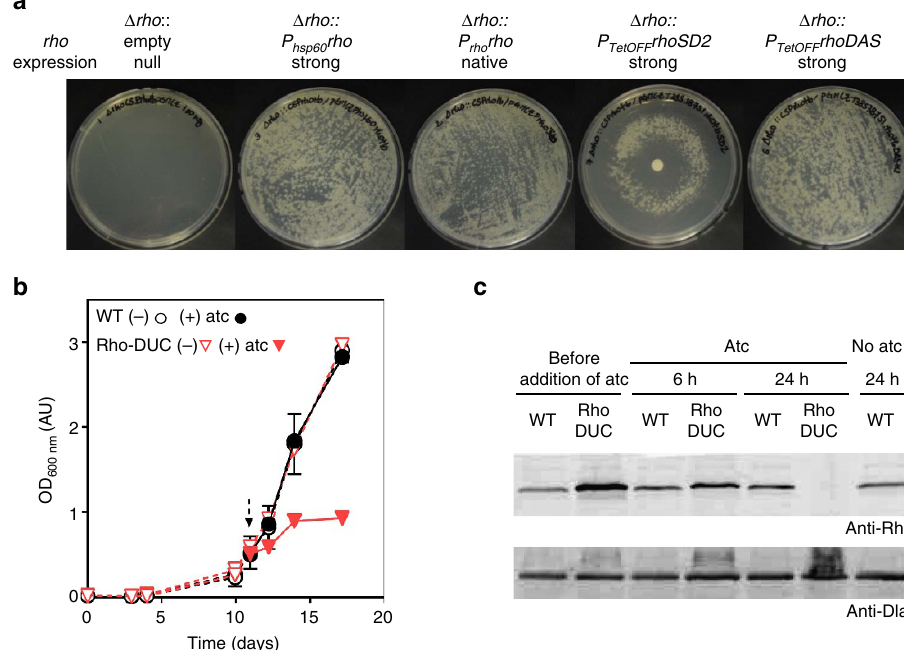
Figure 1 | The gene rho is essential for the growth of M. tuberculosis . ( a ) Phenotypes of different rho mutants on rich solid medium. Rho was either deleted ( D rho) or exchanged against rho expressed under the control of the hsp60 promoter ( P hsp60 rho ), the native promoter ( P rho rho ) or transcriptionally regulated TetOFF promoters ( P TetOFF rho SD2, P TetOFF rho DAS). When applicable, 100ng of atc was added on a disc placed at the centre of the agar plate. ( b ) Growth of WT and Rho-DUC Mtb strains in the presence or absence of atc. The arrow indicates when 1 m gml (cid:2) 1 atc was added. Data are means of duplicate (WT) or triplicates (Rho-DUC) cultures representative of five experiments ( ± s.d., some error bars too small to be seen). ( c ) Western blot to detect the Rho protein in the lysates from cultures shown in ( b ). The entire blots are shown in Supplementary Fig.